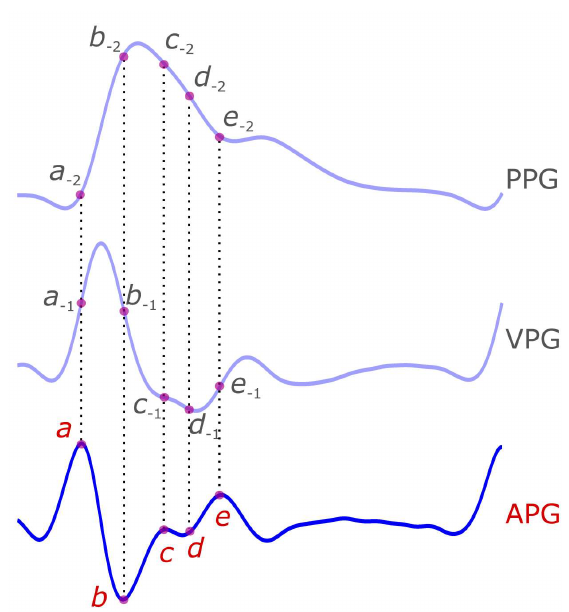
Figure 3. Demonstration of the acceleration photoplethysmogram (APG) signal and its five waveforms ( a , b , c , d, and e ). The five APG waveforms are mapped on the photoplethysmogram (PPG) and the velocity photoplethysmogram (VPG) signals. The subscript of −1 indicates the location of the VPG waveform on the first integral of the APG signal (i.e., VPG), while the −2 indicates the location of the APG waveform on the second integral of the APG signal (i.e., PPG). Note that the negative sign refers to the mathematical integration.